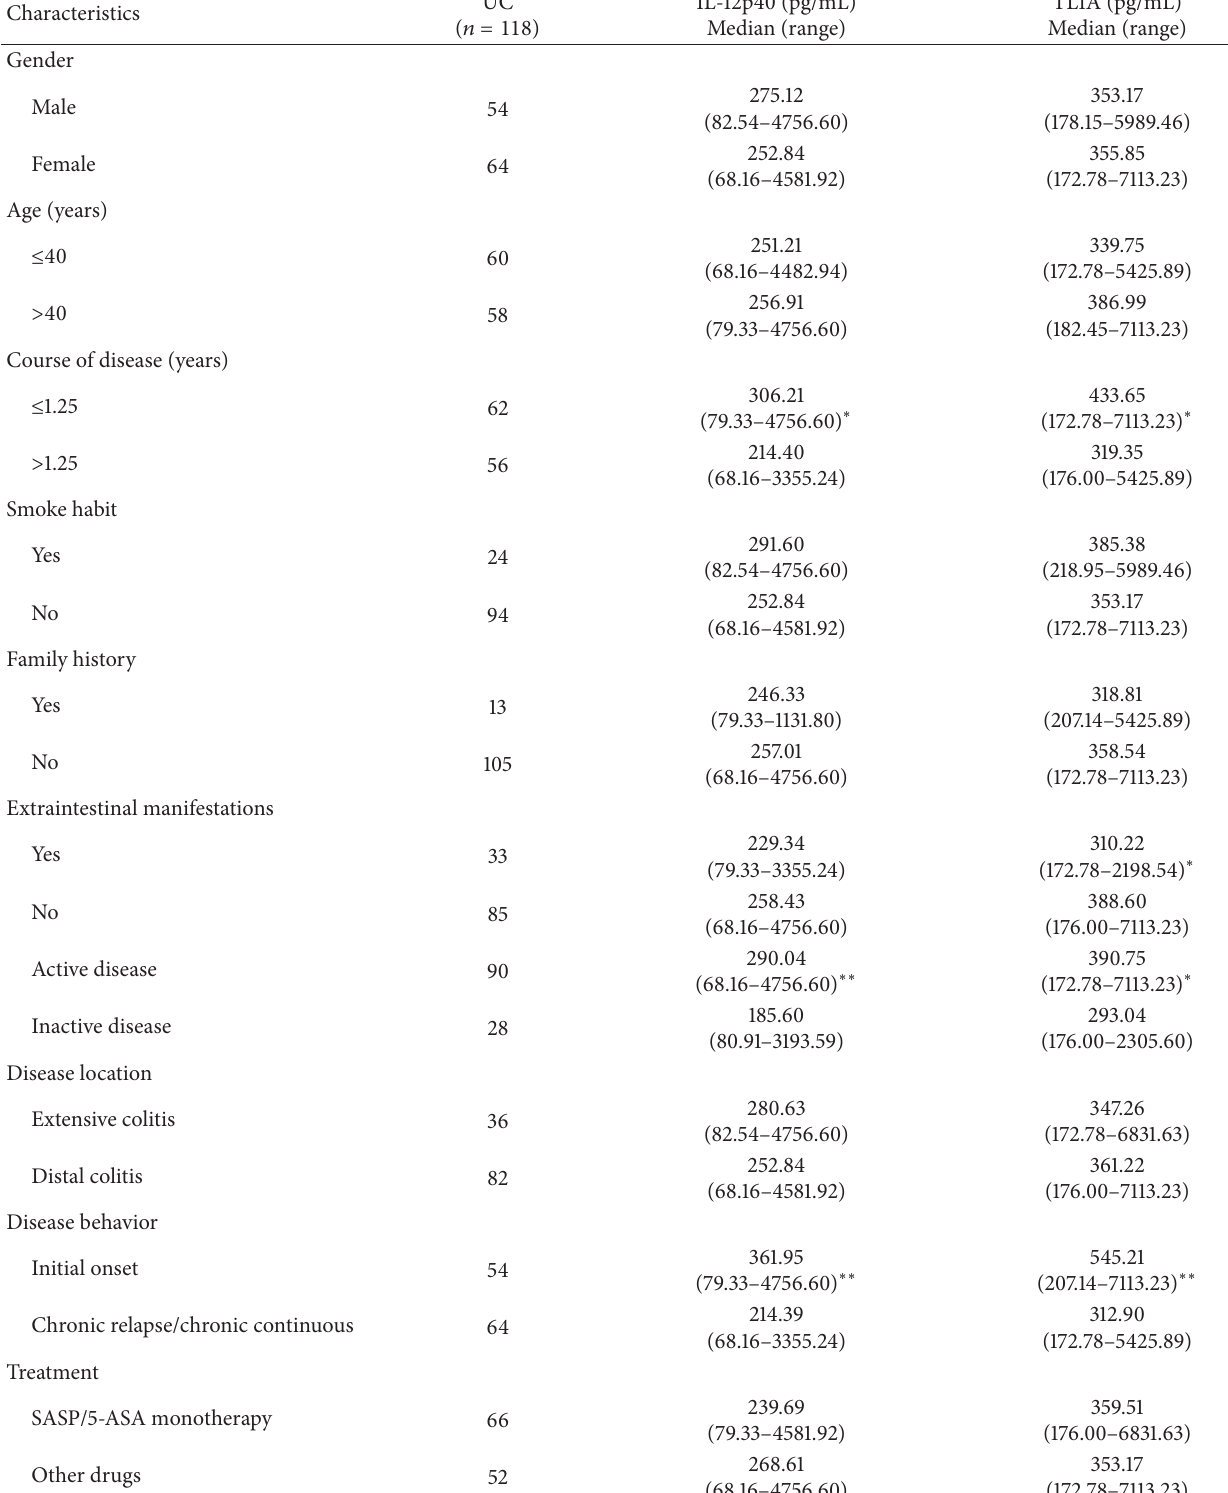
Table 3: Serum IL-12p40 and TL1A levels in patients with ulcerative disease (UC) according to disease